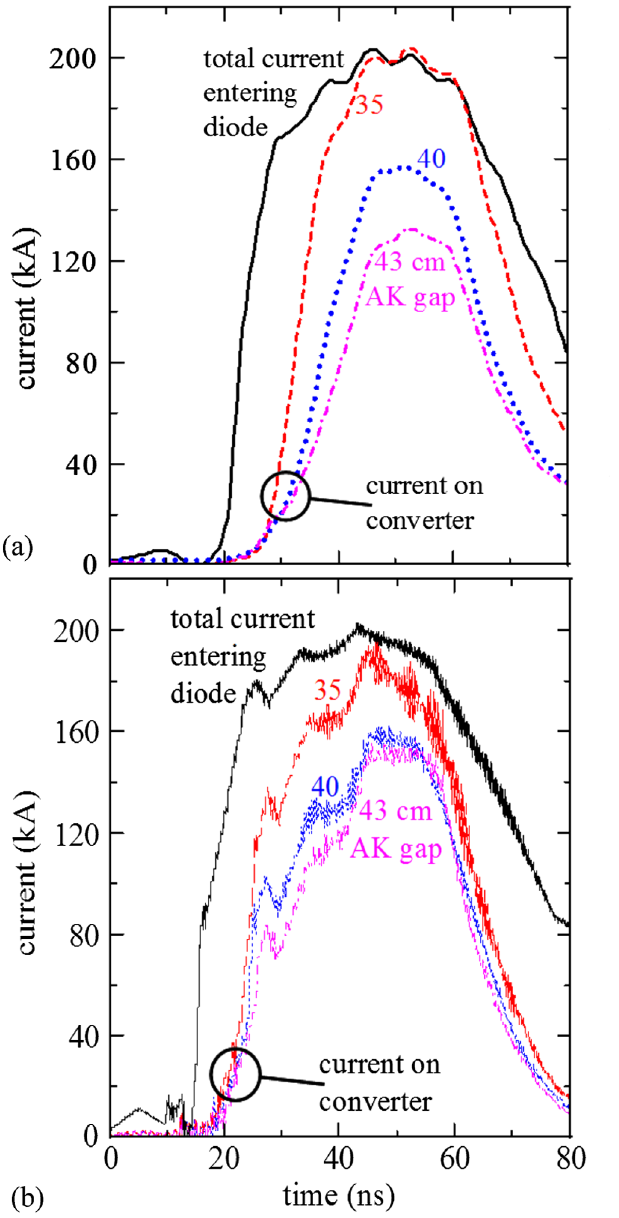
FIG. 6. (a) Electron current on the converter for 35, 40, and 43 cm AK gaps compared to that entering the diode region. is diode Traces are 4 shot averages for each gap. (b) LSP electron currents is the current con V 2 . 8 , X V 2 . 8 , and on the converter for 35, 40, and 43 cm AK gaps compared to that is I is I diode diode con con entering the diode